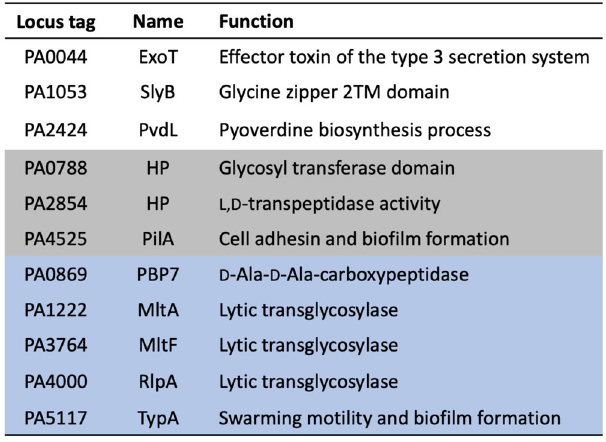
Fig. 3 Select putative binding partners from the eleven LT pulldowns. Binding partners devoid of highlighted color were identi fi ed solely in the RlpA pulldown. Binding partners highlighted in gray were identi fi ed in the RlpA pulldown and from an additional LT pulldown; PA0788 from the SltB1 pulldown, PA2854 from the MltF2 pulldown, and PilA from the MltG pulldown. Binding partners highlighted in blue were identi fi ed from all eleven LT pulldowns. HP denotes hypothetical protein. View Supplementary Tables 2 and 3 for all 71 putative binding partners and for their enrichment data and attributed names, functions, and localizations.